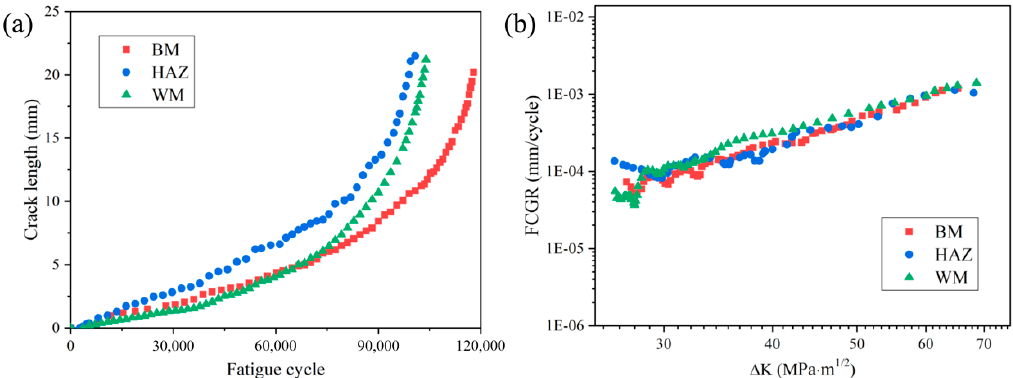
Figure 3. ( a ) Fatigue crack length versus fatigue cycles. ( b ) Fatigue crack growth rate versus the stress intensity factor range.